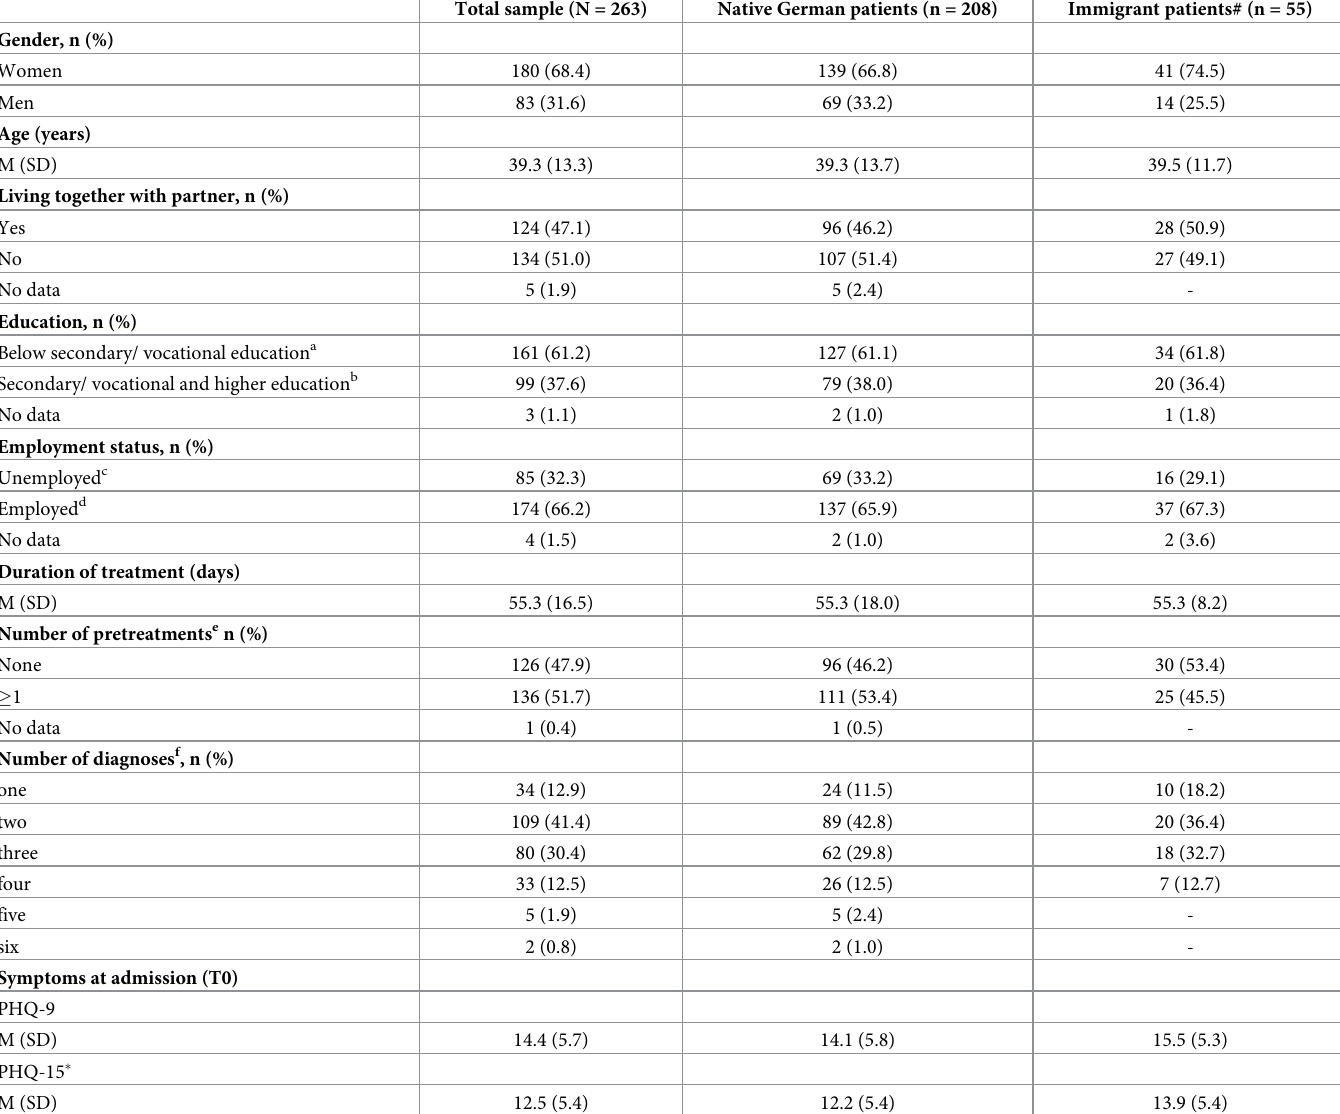
Table 1. Sociodemographic data of the total sample and patients with and without migration status. Total sample (N =